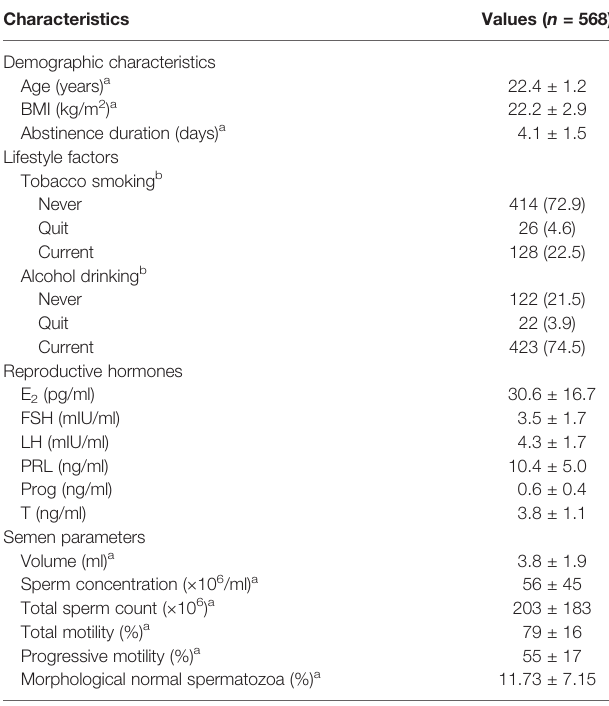
TABLE 1 | Demographic characteristics, lifestyle factors, reproductive hormone levels, and semen parameters of the participants.